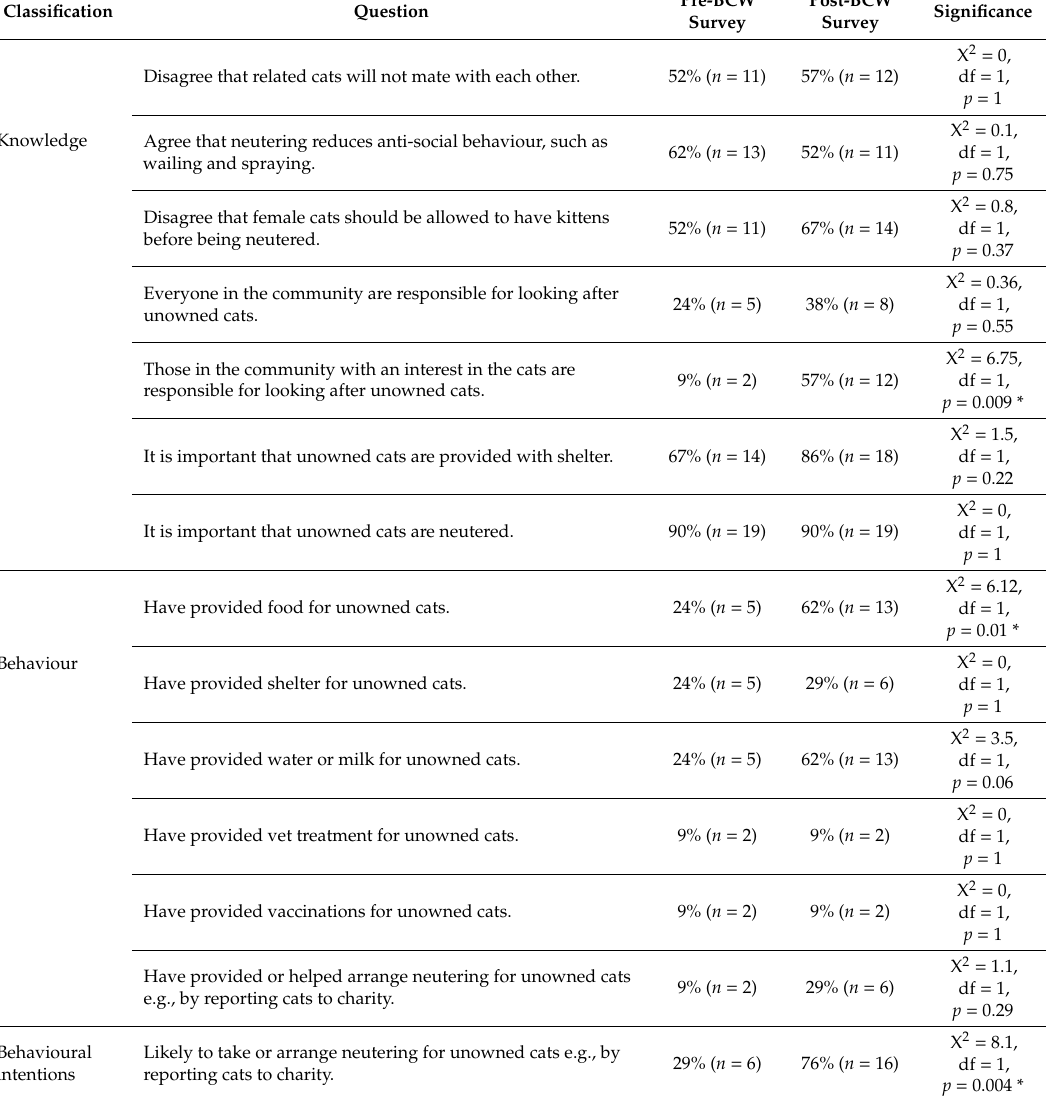
Table 3. Di ff erences in reported knowledge, behaviour and behavioural intentions pre-BCW and post-BCW and any associated